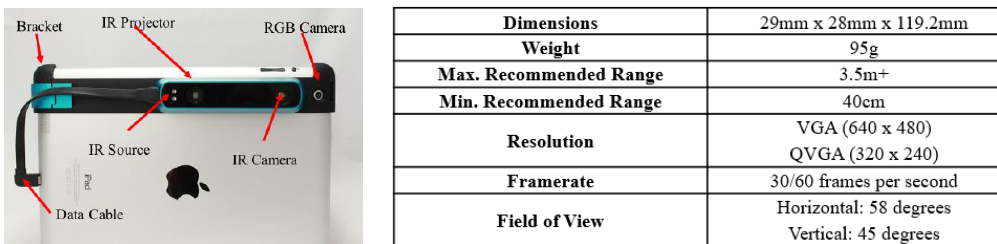
Figure 2. The main elements of hardware used in this paper, which includes one RGB-D camera and